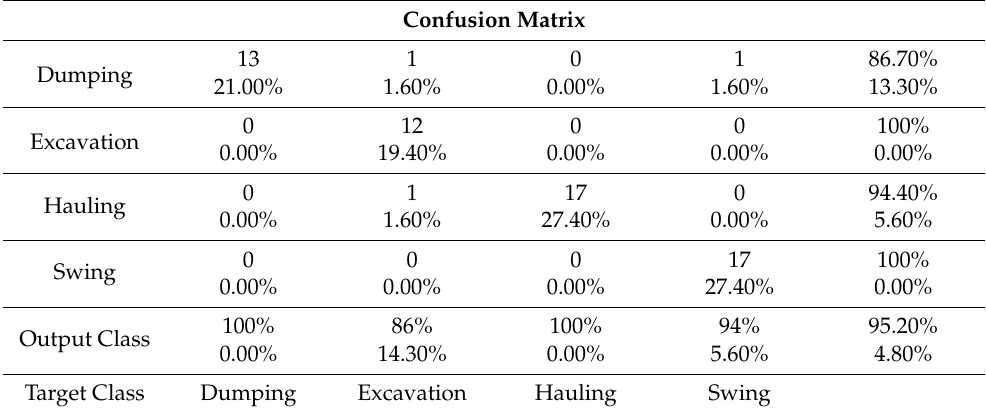
Table 4. Confusion matrix of the validation dataset.